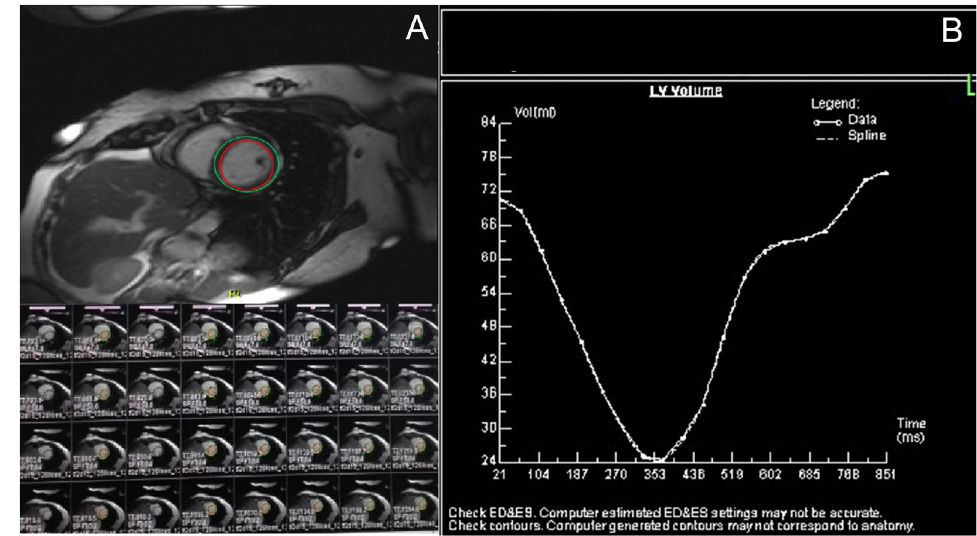
Fig. 2 Procedure for cardiac function analysis using cardiovascular magnetic resonance